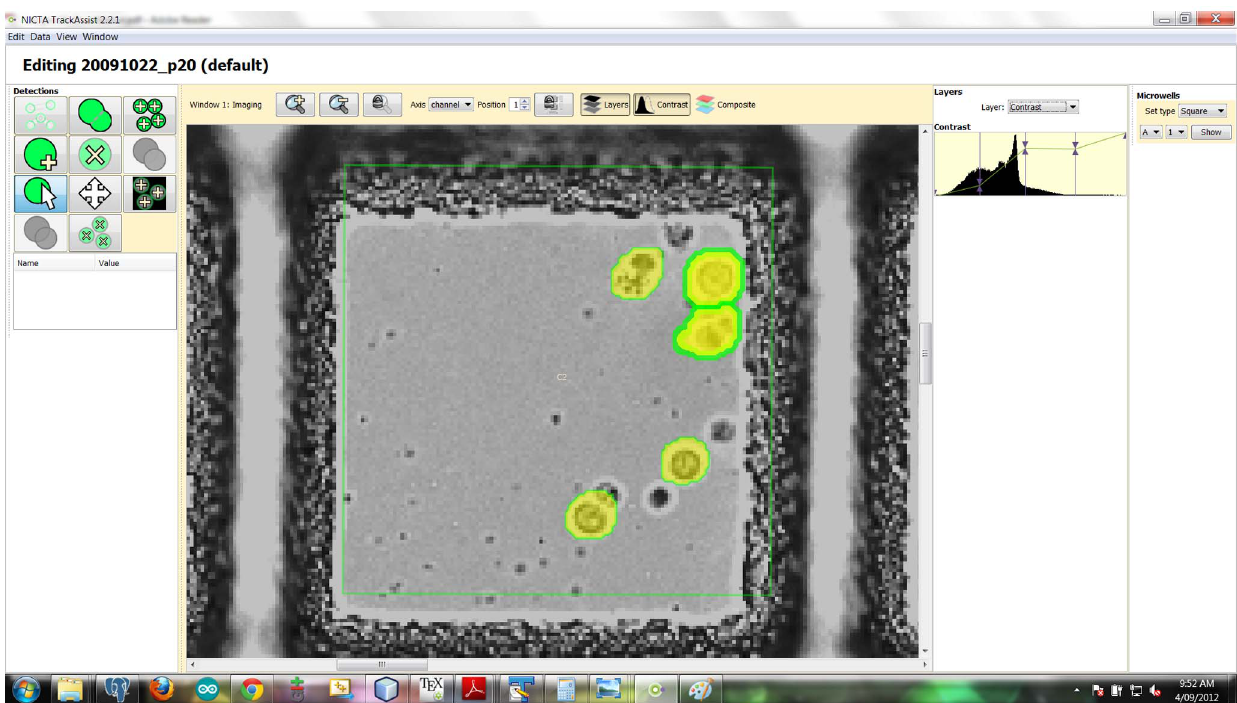
Figure 12. Graphical user interface of the TrackAssist software. The bright field is shown here, with histogram based manual contrast enhancement for viewing purposes. Five segmented cells are shown, two of which are selected. Other objects in the well are debris. The detection editing tools are shown in a panel on the left. In row-major order from top-left, these are: De-select all tracks and detections; merge selected detections; automatically create detections (by background modelling and motion detection); create detection; delete selected detections; cut brush from selected detection contour; select detections; move detection; automatically create detections (based on thresholded constant fluorescence); add brush area to selected detection contour; delete all detections in range of images.